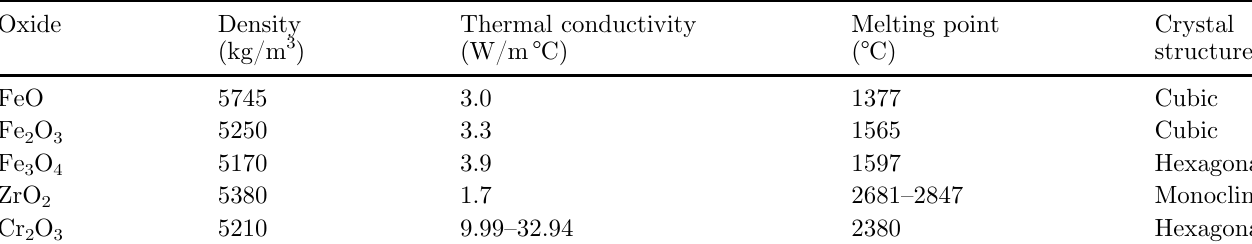
Table 1. Properties of different oxides at room temperature